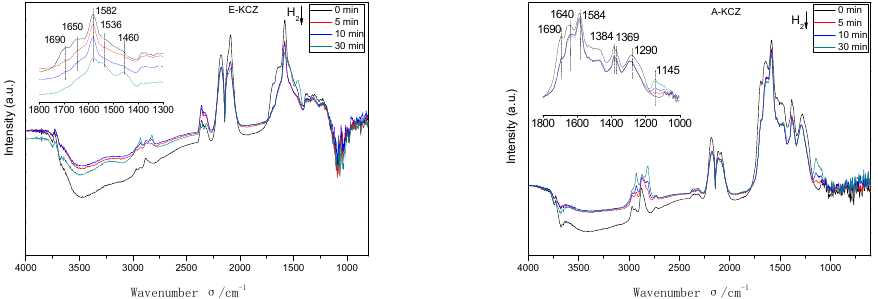
Figure 8. Infrared spectra of E, A-KCZ catalysts exposed to H 2 after CO adsorption.